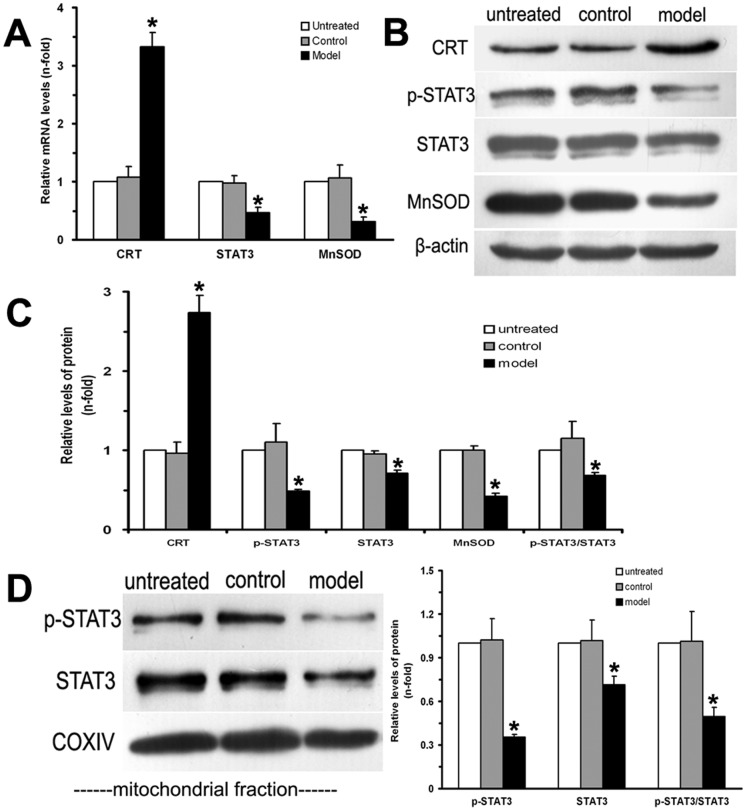
Alterations of CRT-STAT3 signaling pathway in this rat model of DCM.A: Real-time PCR revealed that CRT, STAT3 and MnSOD mRNA expression in the hearts from DCM have changed significantly. Results are expressed as fold increase or decrease over untreated group and GAPDH was served as an internal control (n = 6, 9 and 16 respectively). B: The protein expression of CRT, phosphorylated and total STAT3, and MnSOD in homogenates of rat left ventricular myocardium was determined by western blot. β-actin was used as a loading control. A representative blot is shown. C: Quantification analysis of the protein levels as shown in part B using the quantity one software. D: The protein levels of phosphorylated and total STAT3 in cardiac mitochondria were determined by western blot. COXIV was used as a loading control for the mitochondrial protein. A representative blot is shown in the left panel, and quantitative analysis results are shown in the right panel. The protein expression is represented as the mean ± SD from 6 independent rats per group, and each western blot was performed in triplicate. *P<0.05 versus the control group.